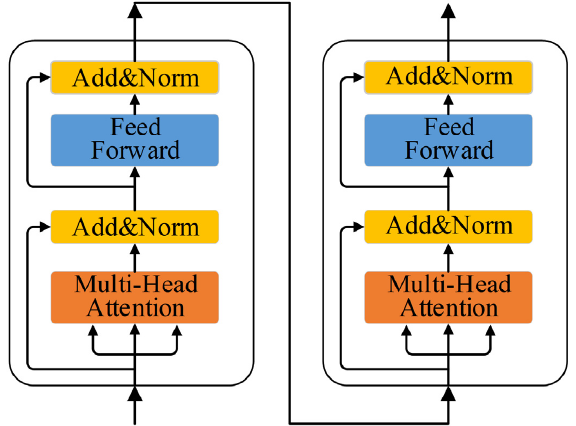
Figure 2. Backbone structure and multilevel feature fusion.